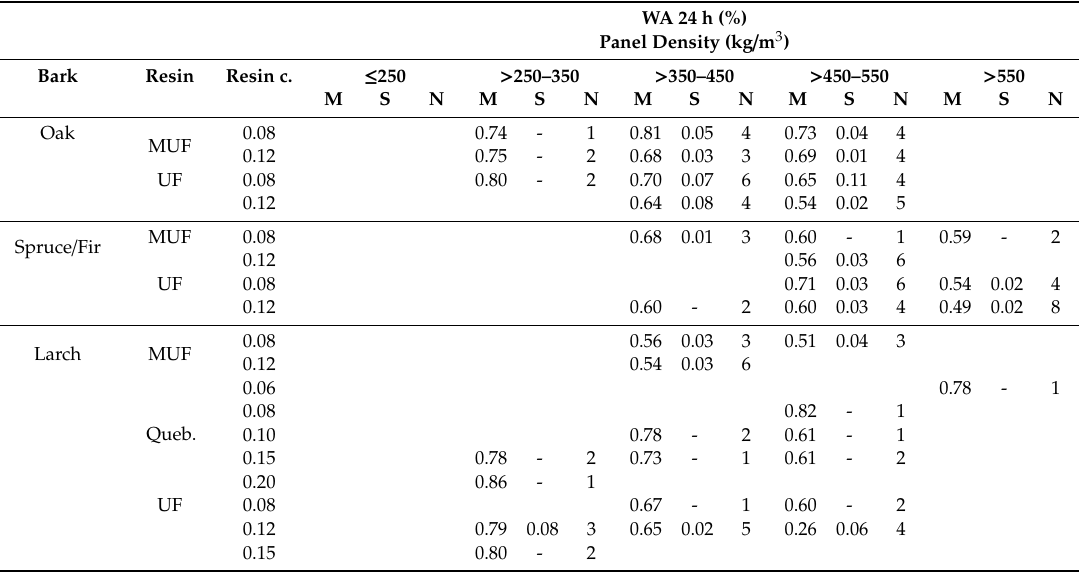
Figure 7. WA after 24 h of water immersion according to density, bark type, resin content, and particle size. Table 8. WA after 24 h of water